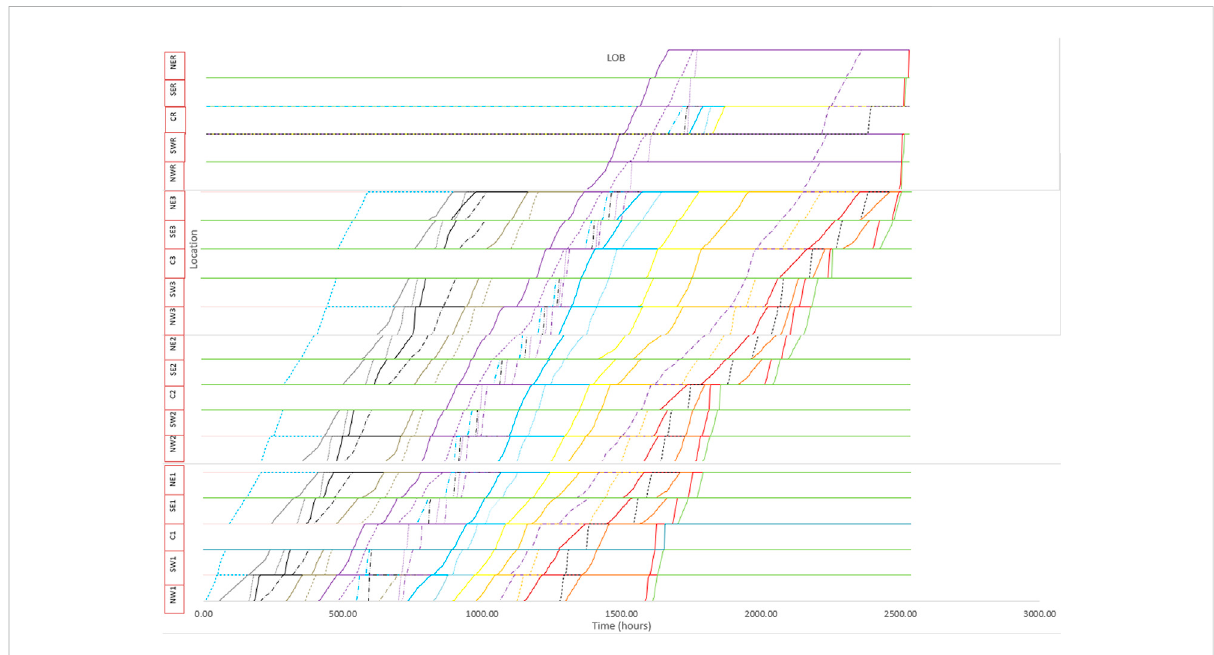
FIGURE 7 Flowline diagram of a representative pull run.